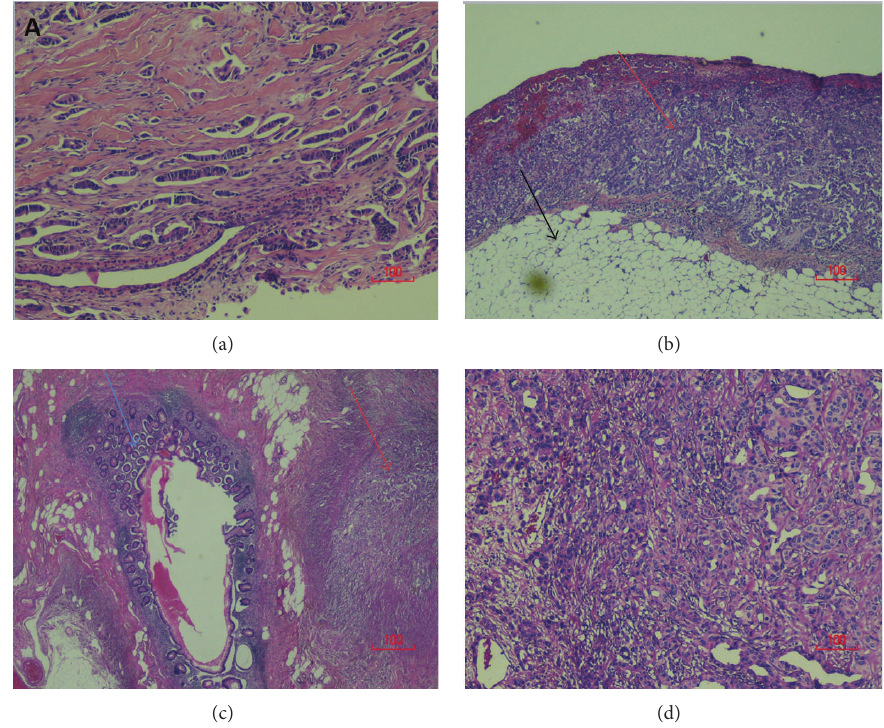
Figure 2: (a) Core needle biopsy of the left breast shows an invasive, moderately differentiated infiltrating ductal cell carcinoma with microvascular invasion (H&E, 100x). (b) An invasive, poorly differentiated carcinoma (red arrows) involving the intra-abdominal adipose tissue (black arrow) (H&E, 40x) and (c) the serosal aspect of the appendix (blue arrow = appendiceal mucosa; red arrow = serosal tumor) (H&E, 20x) consistent with breast cancer. (d) Tumor in appendiceal serosa (H&E, 100x).